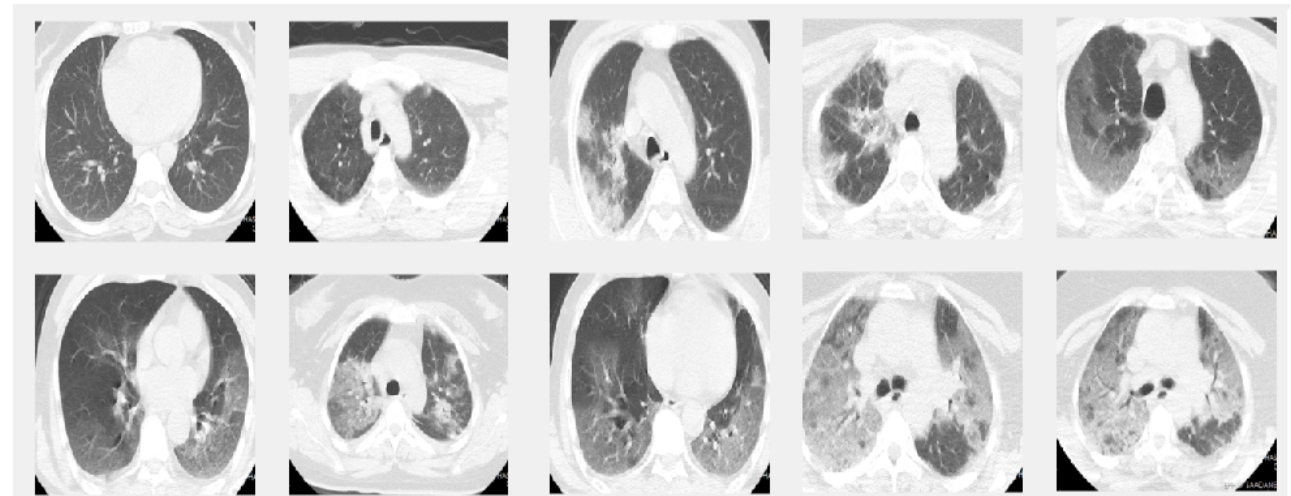
Figure 2. Sample images from the CT dataset. The images in the first row give 5 sample slice images about 0–10–20–30–40% COVID-19 infection in the lungs and the second rows show 50–60–70–80–90%